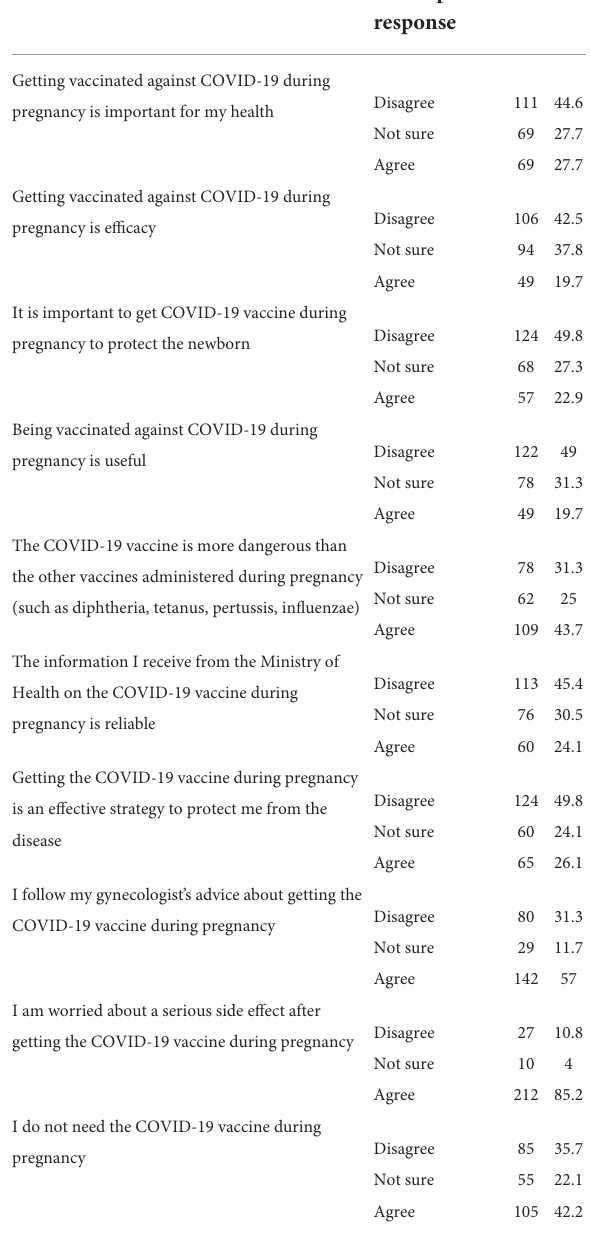
TABLE 3 Descriptive characteristics of respondents’ VHS index about the COVID-19